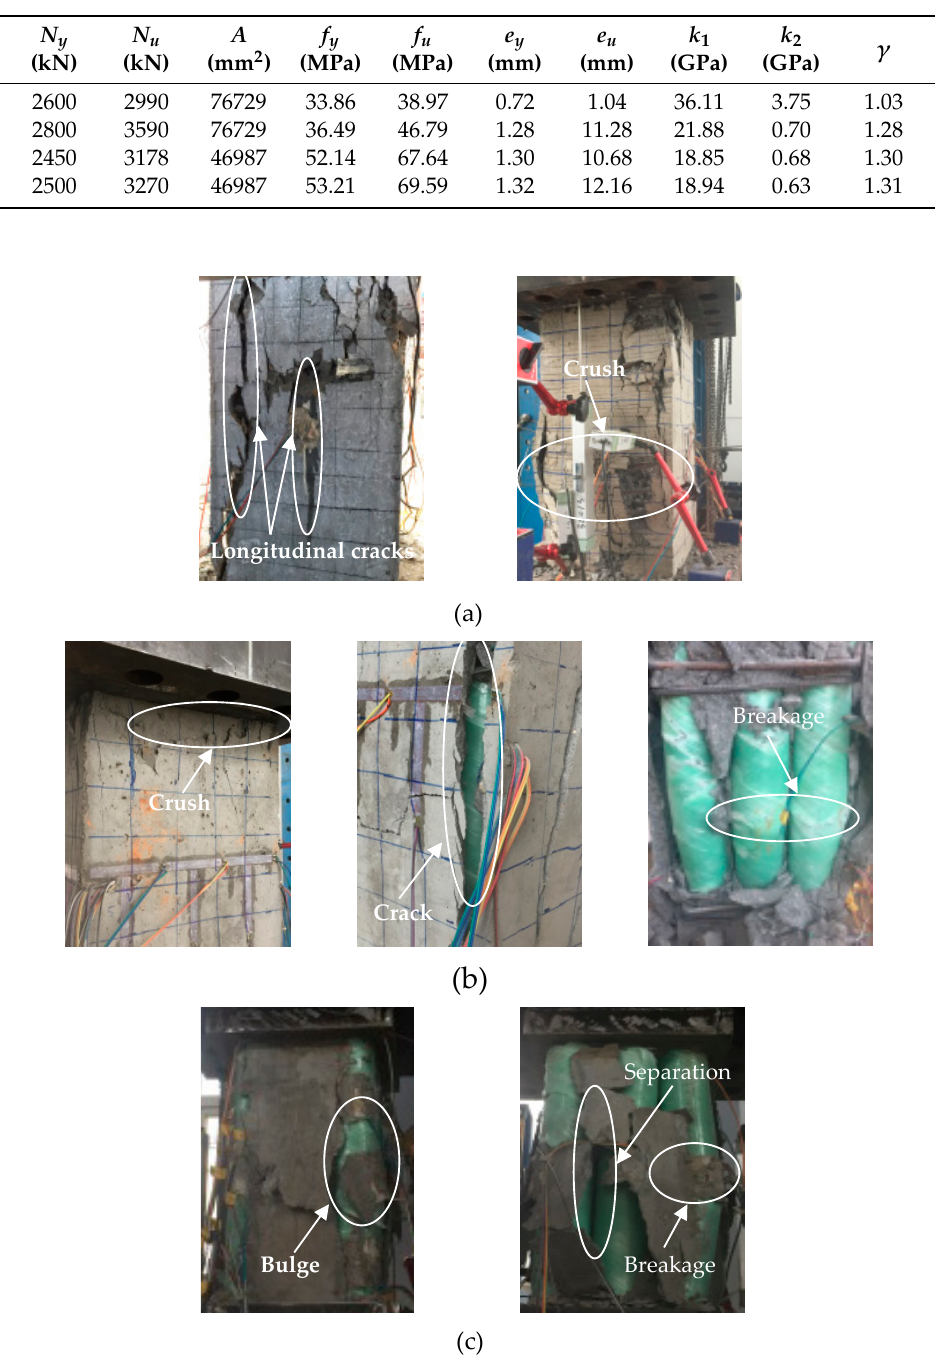
Figure 4. Failure modes of all the specimens: ( a ) specimen T0, ( b ) specimen T8 and ( c ) specimens T8N.